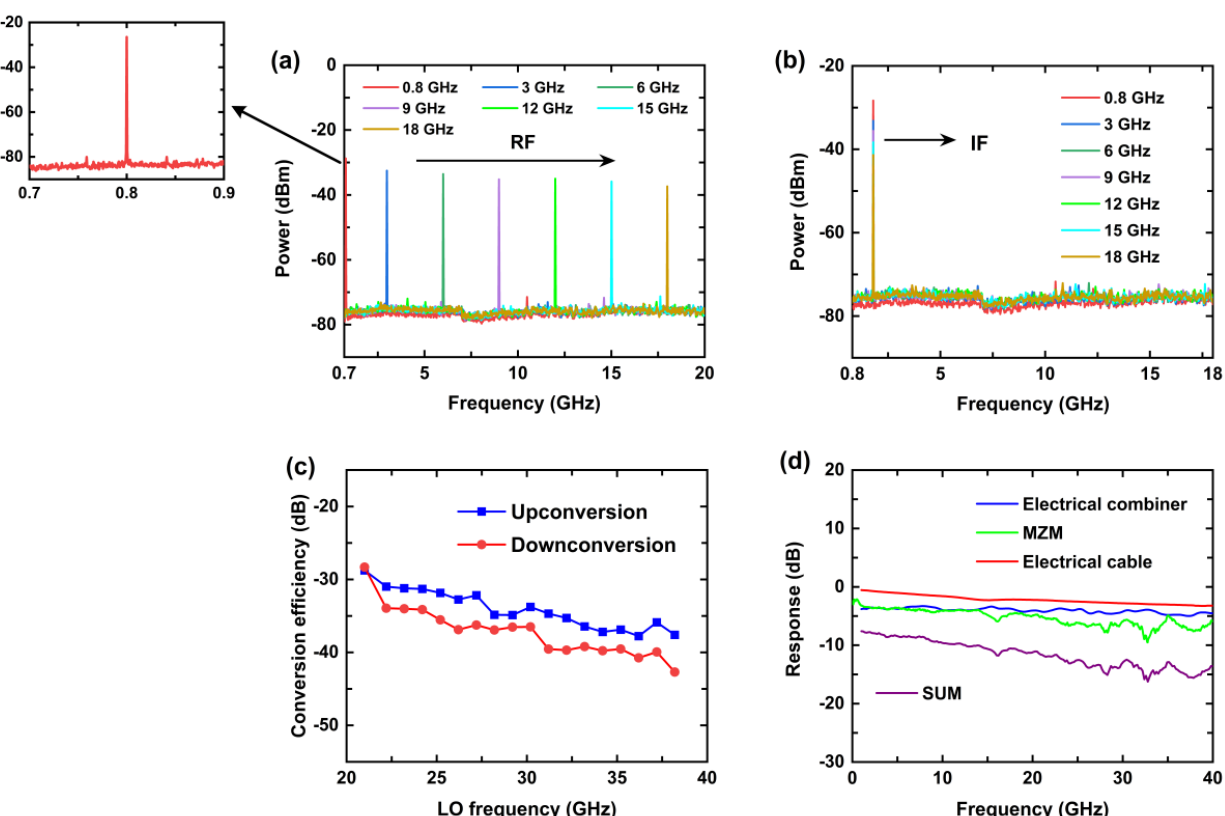
Figure 7. Measured output electrical spectrum of both the upconversion ( a ) and downconversion ( b ) when RF signal is tuned from 0.8 to 18 GHz. Conversion efficiency ( c ) when LO frequency is tuned from 21–38.2 GHz (corresponds to the RF signal from 0.8–18 GHz) and power responses ( d ) of electrical cable, electrical combiner, and MZM.